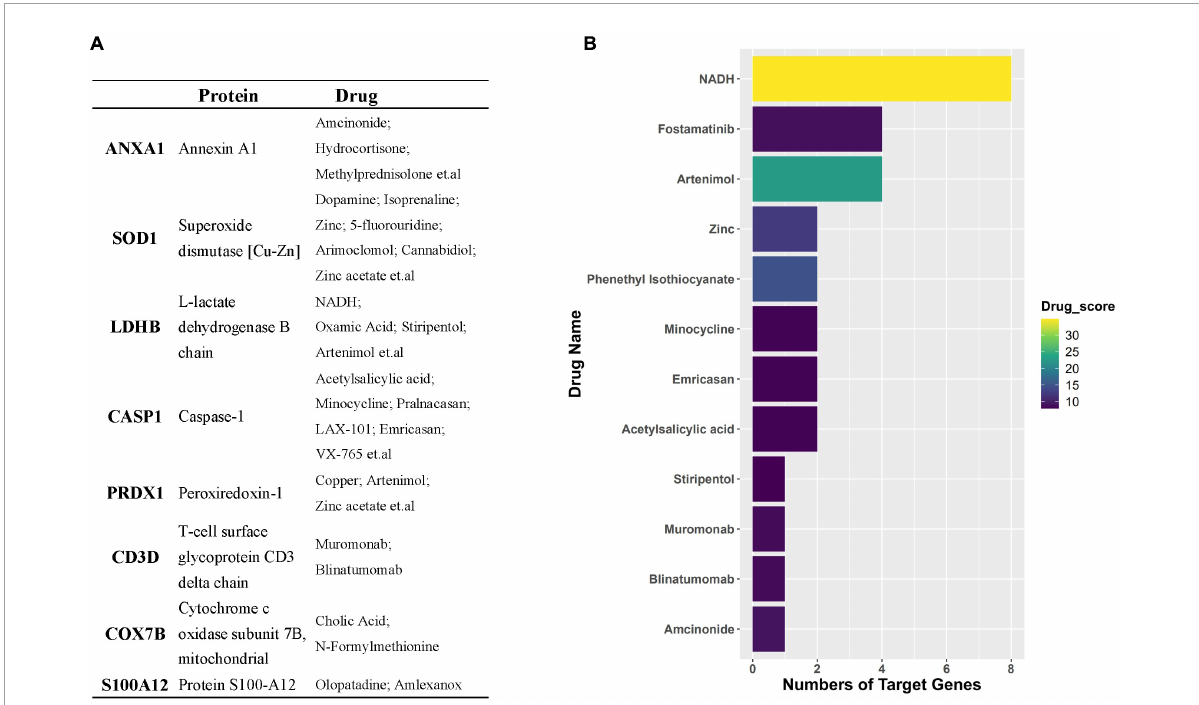
FIGURE5 (A) Table represents target genes, corresponding proteins, and their potential drugs. (B) Bar plot demonstrates potential drugs, of which the horizontal axis represents the number of gene targets of the